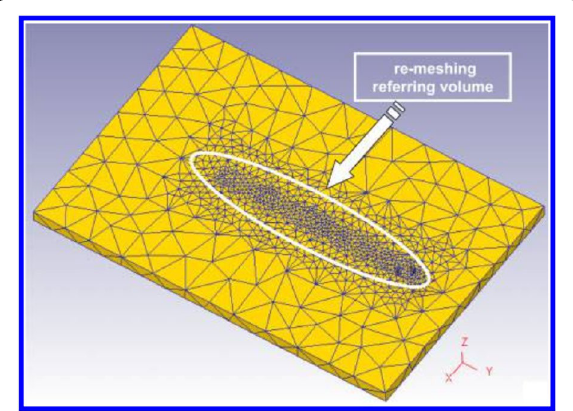
Figure 48 Mesh inside the domain which shows smaller mesh size in the welding zone [130]